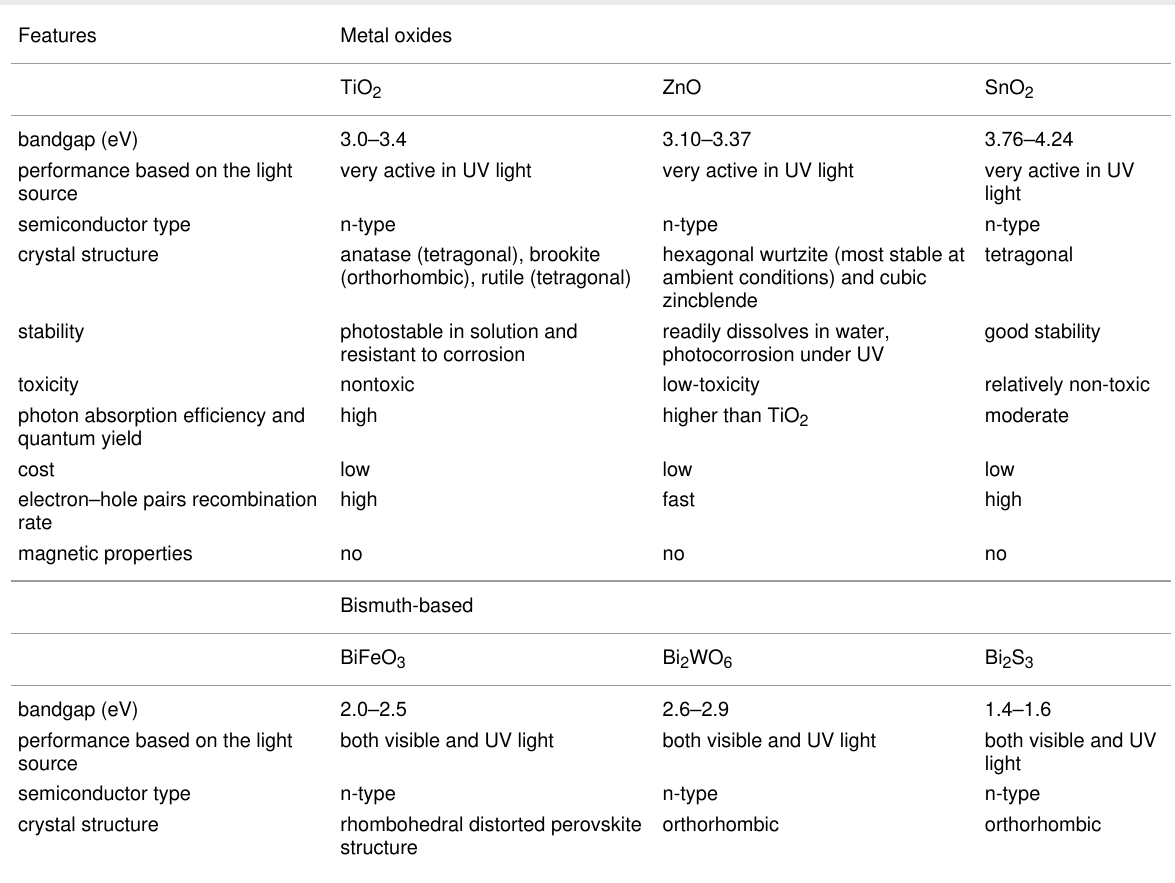
Table 1: Comparison of nanometre-sized metal oxide-based and bismuth-based photocatalysts.